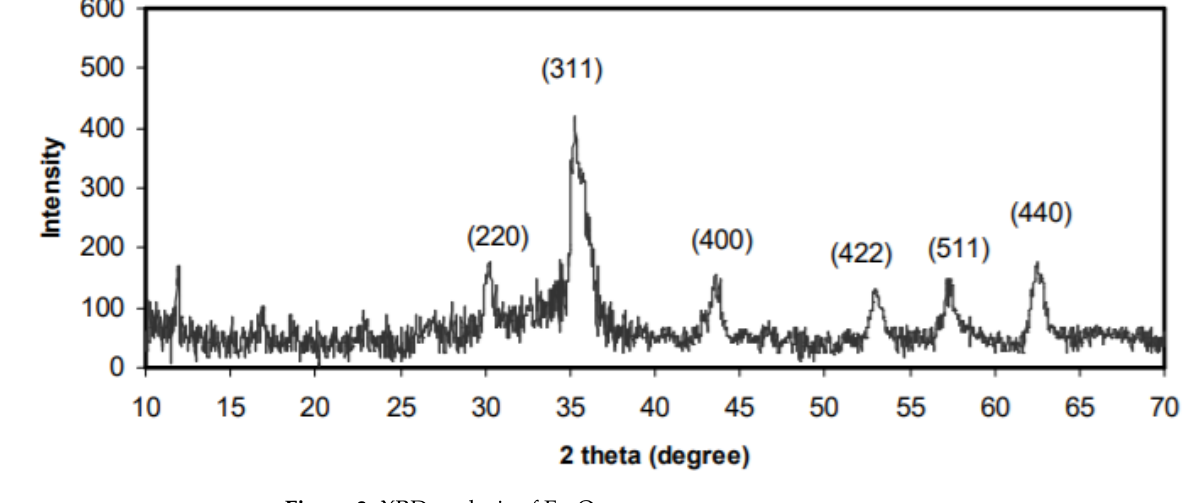
Figure 3. XRD analysis of Fe 3 O 4